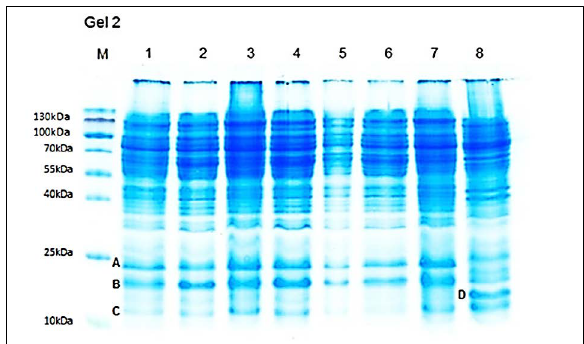
Figure 4: Sodium dodecyl sulfate polyacrylamide gel electrophoresis (SDS-PAGE) patterns of total proteins from lactic acid bacteria showing similarities in protein patterns.